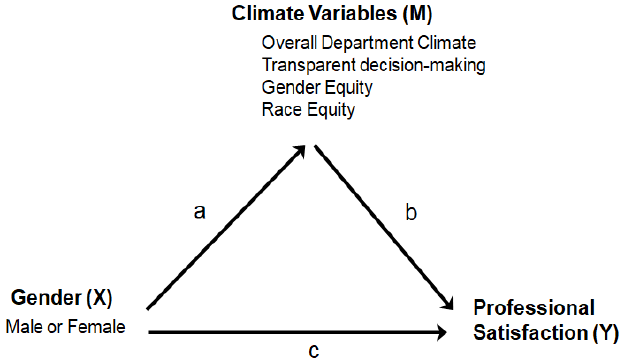
Figure 1. Conceptual mediational model examining whether gender differences in faculty members’ professional satisfaction is mediated by differential perceptions of department climate.